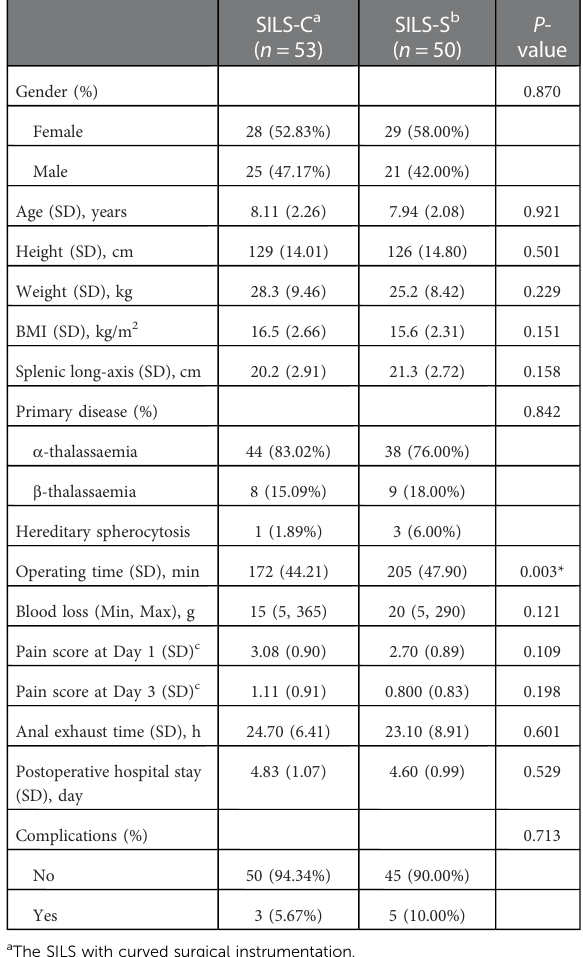
TABLE 3 The baseline and perioperative data of SILS-C versus SILS-S.